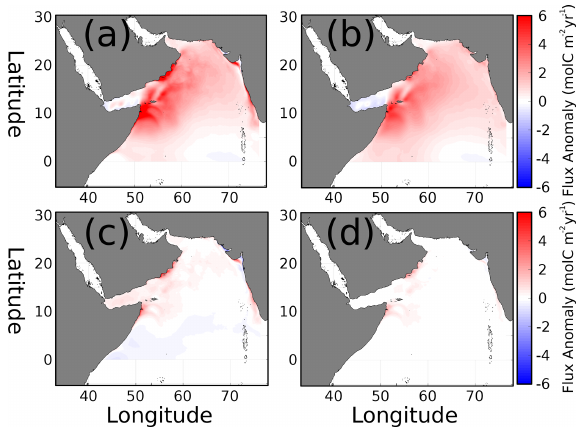
Figure 7. (a) Anomaly of air–sea CO 2 flux during the summer mon- soon (JJAS; molCm − 2 yr − 1 ). Summer flux anomaly contributions due to (b) wind, (c) p CO 2 , and (d) cross-terms in Eq.